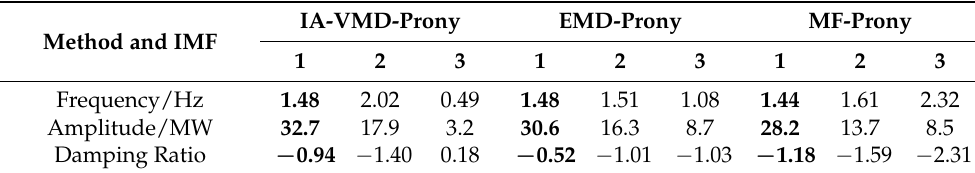
Table 2. Modal identification of the obvious oscillation signal.